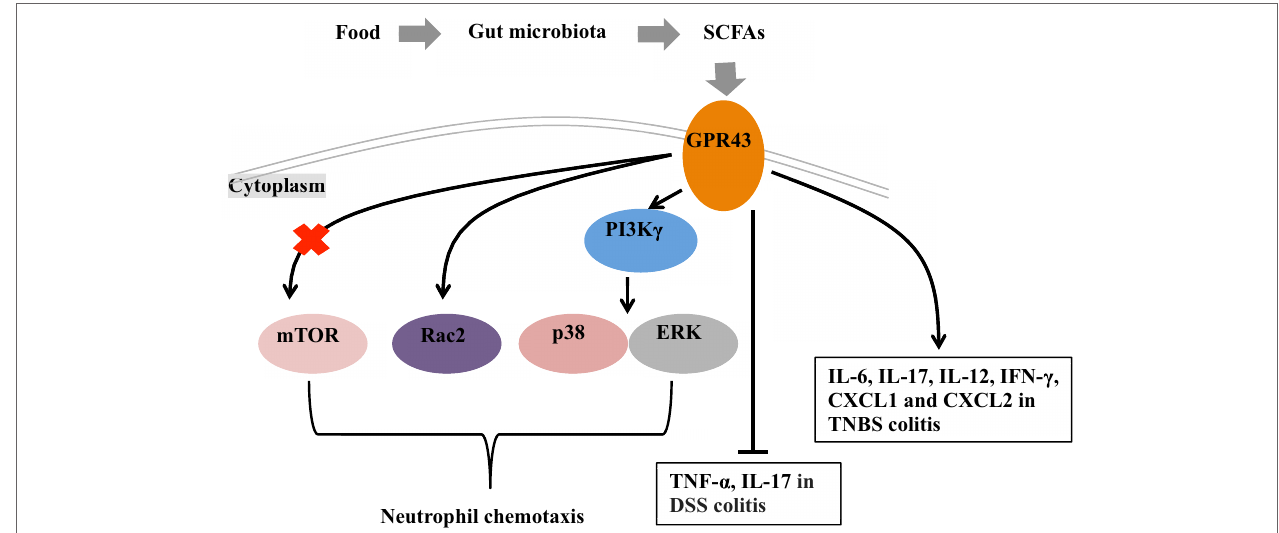
FiGURe 1 | Mechanisms of short chain fatty acids (SCFAs)-mediated intestinal health. Under fed conditions, SCFAs are produced in the gut by fermentation of the fiber by the gut microbiota. G protein-coupled receptor 43 (GPR43), which serve as the receptor of SCFAs, plays a role in the intestinal inflammation through regulating the neutrophil chemotaxis and mediating the cytokine expression. The mechanisms for GPR43 to regulate the neutrophil chemotaxis are associated with the activation of mTOR, Rac2, p38, and ERK. In the absence of GPR43, IL-17 and TNF- α are highly produced in dextran sulfate sodium (DSS)-induced colitis model and lead severe colitis symptoms. GPR43 is also important for the induction of inflammatory cytokines (i.e., IL-6, IL-17, IL-12, and IFN- γ ) and chemokines (CXCL1 and CXCL2) in TNBS-induced colitis, and further promote the clearance of Citrobacter rodentium infection in this